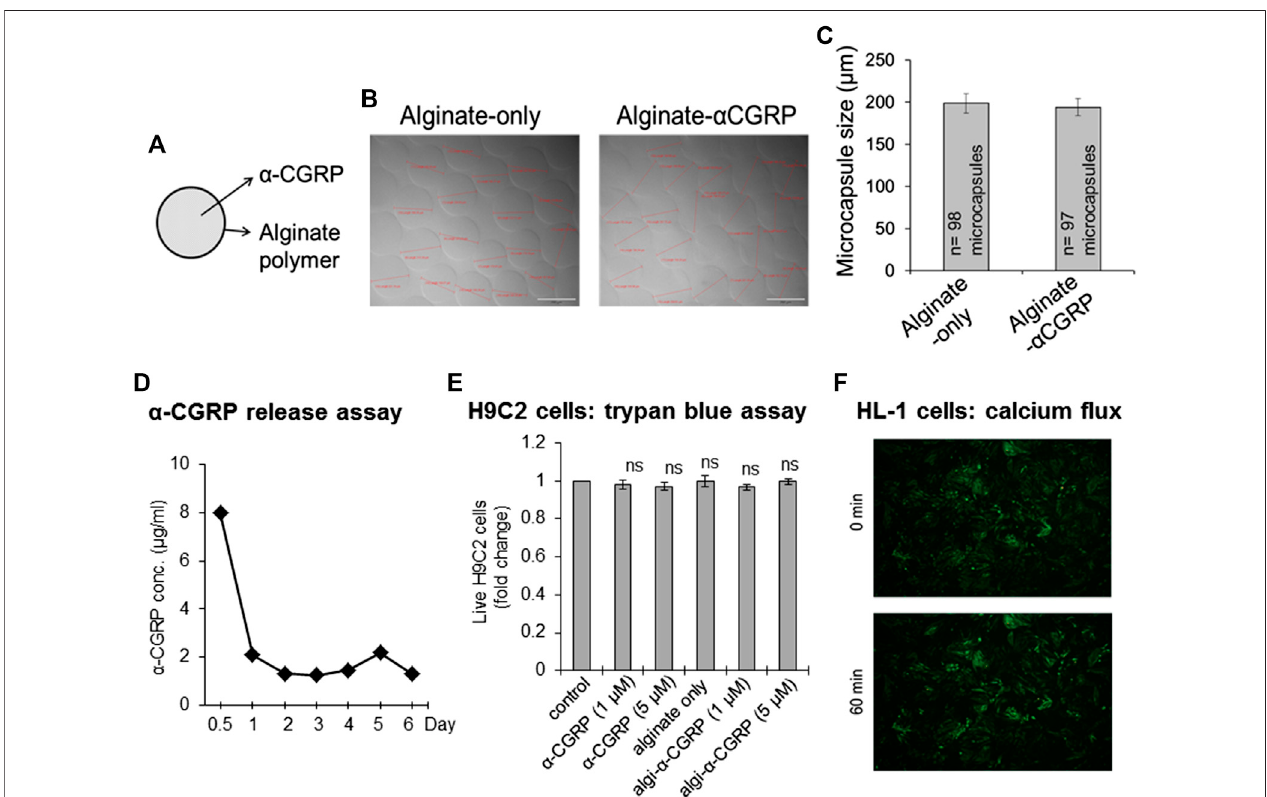
FIGURE 1 | Preparation of the alginate- α -CGRP microcapsules. (A – C) An electrospray method was used to encapsulate α -CGRP in an alginate polymer. The prepared alginate-only and alginate- α -CGRP microcapsules were photographed (B) and their size was measured and plotted (C) . (D) An in vitro α -CGRP release assay showingtheamountof α -CGRPreleasedinthesupernatantfromalginate- α -CGRPmicrocapsules. (E) BardiagramshowingthenumberofliveH9C2cells,asmeasured by trypan-blue cell viability assay, after 7 days incubation with different concentrations of α -CGRP-alone, empty-alginate microcapsules, and alginate- α -CGRP microcapsules. ns, not signi fi cant compared to control. (F) The viability of mouse HL-1 cardiac cells in the presence of alginate- α -CGRP microcapsules (10 µM) was determined by an in vitro calcium fl ux fl uorescence assay as discussed in the methods section. HL-1 cells stained with Fluo-4AM dye were imaged using EVOS auto-F2 microscope at 0 and 60 min after the addition of alginate- α -CGRP microcapsules (10 µM).